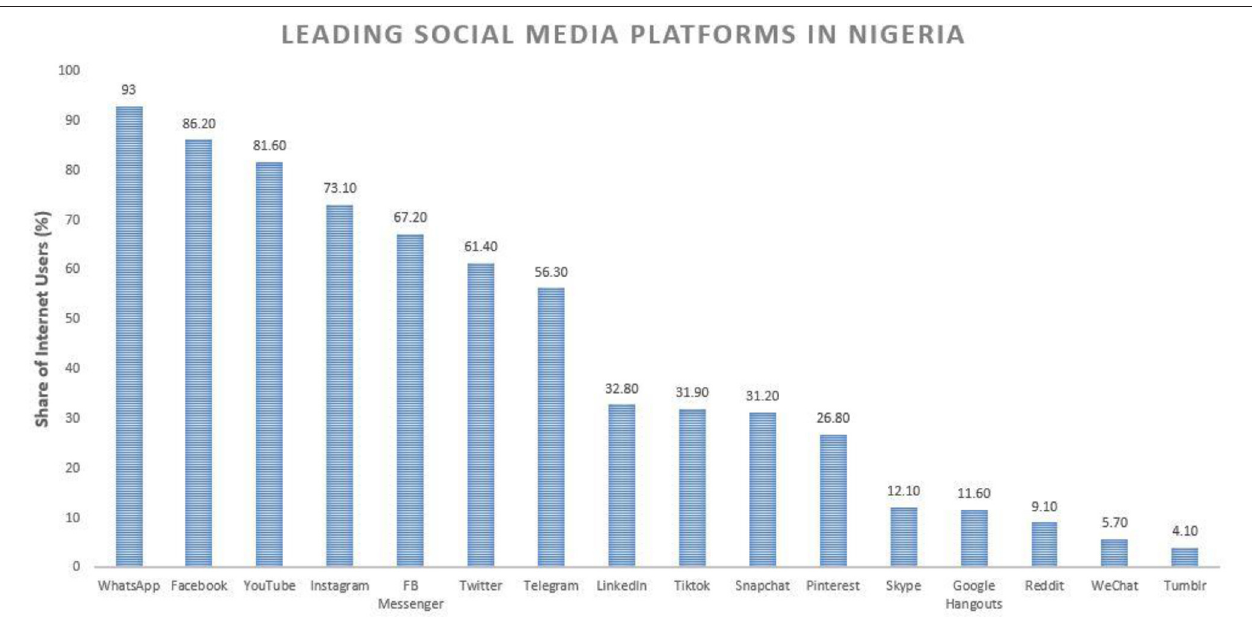
FIGURE 1 | A graph highlighting the popularity of various social media apps/sites commonly used in Nigeria. The information is based on survey data from internet users aged 16–64 years, as of the third quarter of 2020 (https://www.statista.com/statistics/1176101/leading-social-media-platforms-nigeria/)